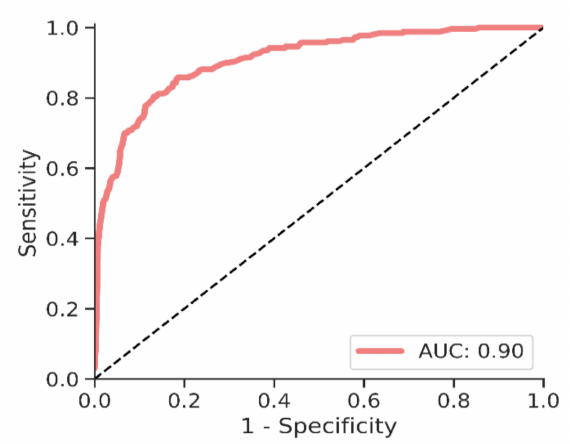
Figure 1. ROC curve for diagnosis of all cancers (full model). At 95% specificity, the individual organ models ranged in sensitivity from 30% for breast cancer to 80% for bladder cancer, with sensitivities higher than 50% for prostate (72% (CI: 56, 88) sensitivity), lung (67% (CI: 50, 84) sensitivity), liver (63% (CI: 45, 81) sensitivity), and pancreas (52% (CI: 37, 67) sensitivity). At 99% specificity, the individual organ models ranged in sensitivity from 16% for breast cancer to 62% for prostate